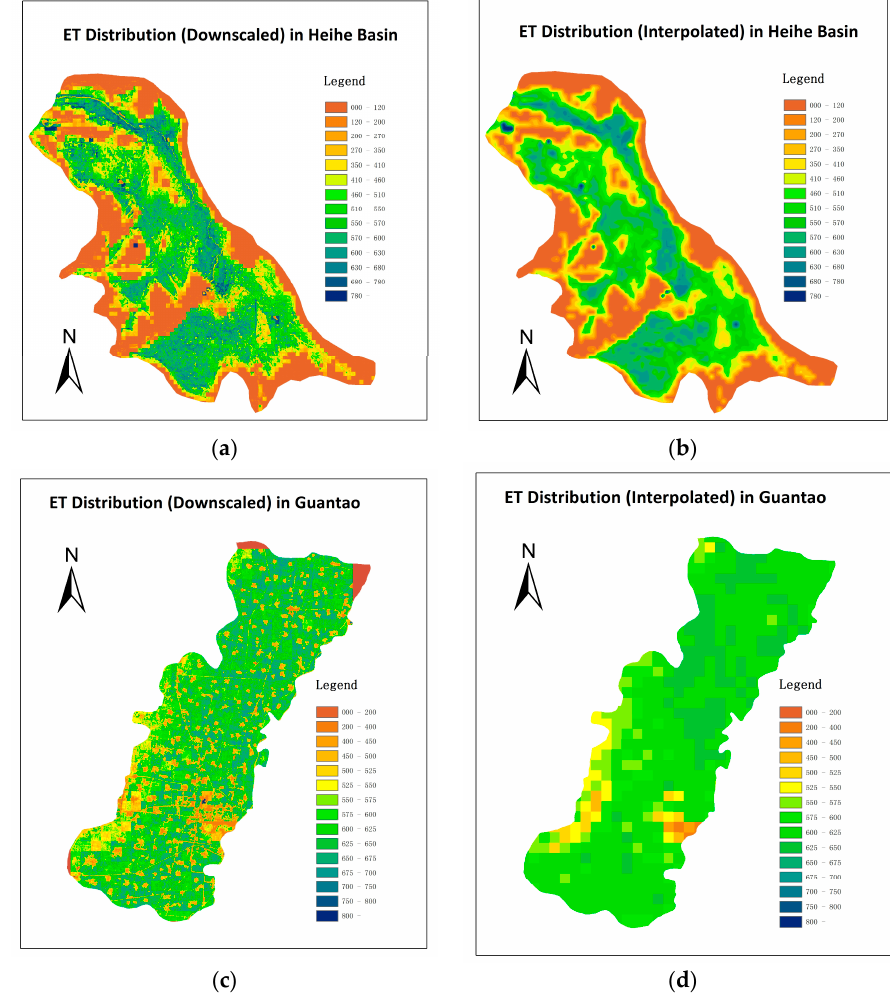
Figure 4. Downscaled ET distributions in the growing season in ( a ) Heihe and ( c ) Guantao and the interpolated map in ( b ) Heihe and ( d ) Guantao. interpolated map in ( b ) Heihe and ( d )